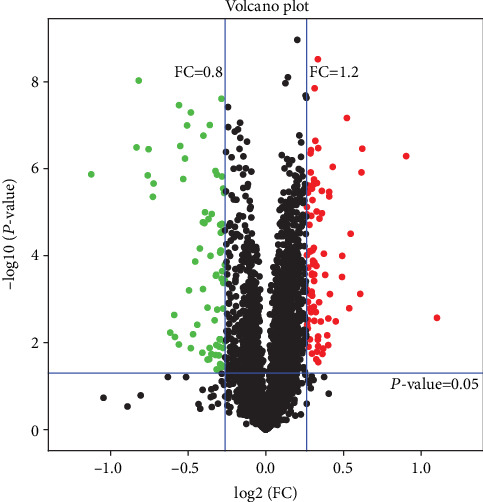
Volcano plot of differentially expressed proteins in kidney tissues. All proteins were plotted with log2 fold change on the x-axis and − log10 (P value) on the y-axis. The red dots in the upper right (ratio> 1.2) and the green dots upper left (ratio< 0.8) sections with P < 0.05 represent proteins that were significantly up and down regulated between the two group. Black dots are proteins that were the same in the two compared groups.